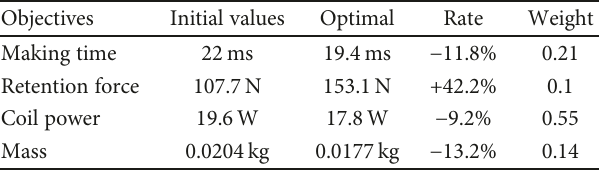
Table 3: The optimal and initial values of each objective. Objectives